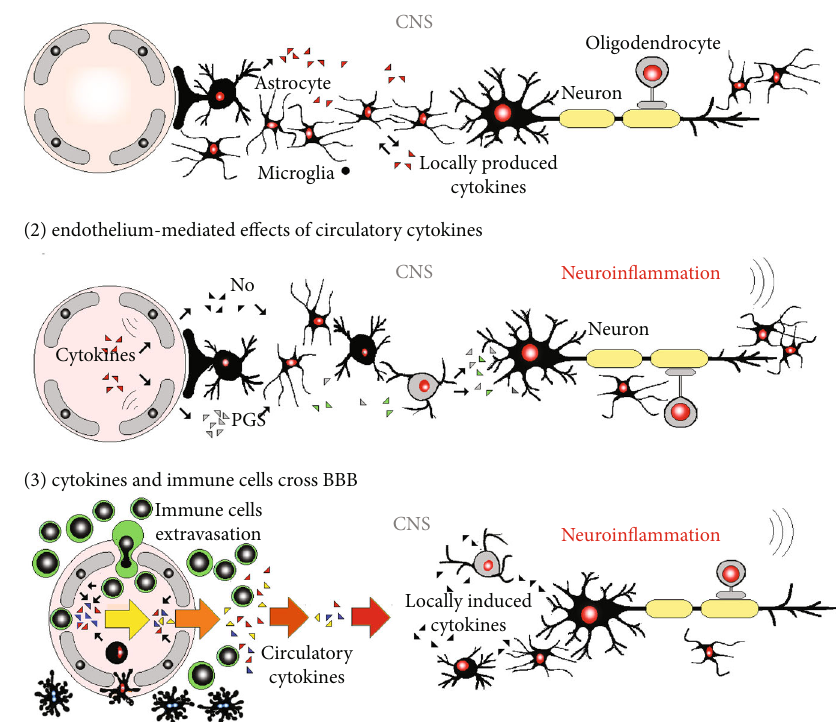
Figure 1: Essential ways cytokines a ff ect the brain. (1) De novo synthesis of cytokines in the CNS in homeostatic conditions is clear. (2) Peripheral cytokines can induce brain cytokine synthesis. Also, cytokines can act centrally via endothelial cells. Cytokine-endothelial cell interaction triggers the release of second messengers like nitric oxide (NO) and prostaglandins (PGS) with central e ff ects. Hence, the signal mediated by a cytokine as IL-1 β can be transduced from the periphery without crossing the BBB. (3) Systemic administration of IL- 1 β and TNF- α to experimental animals decreases BBB selectivity. Cytokines induce glial stimulation.